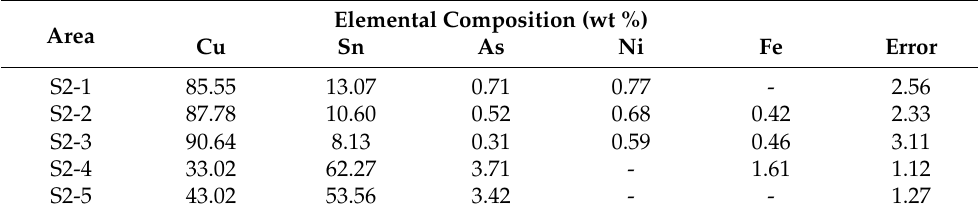
Table 2. Elemental chemical composition of the areas on the outer surface of the gilding and in the section of the two edges, the fresh crack and the old cracked incision,